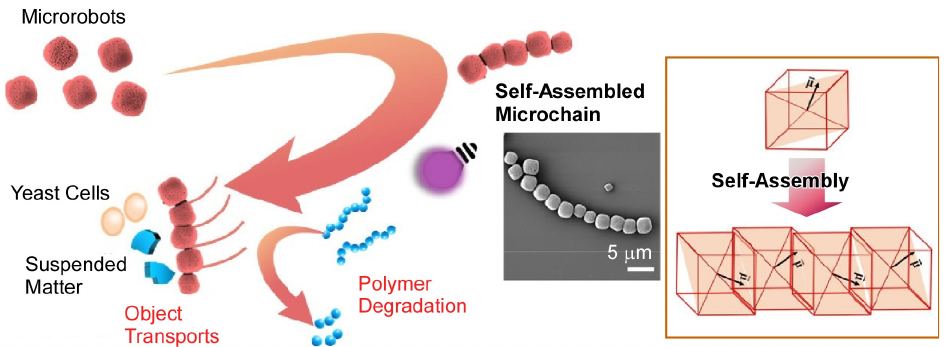
Figure 16. Shape-controlled microrobots to form chain-like aggregate structures. Reprinted with permission from Reference [160]. Copyright 2022 American Chemical Society.